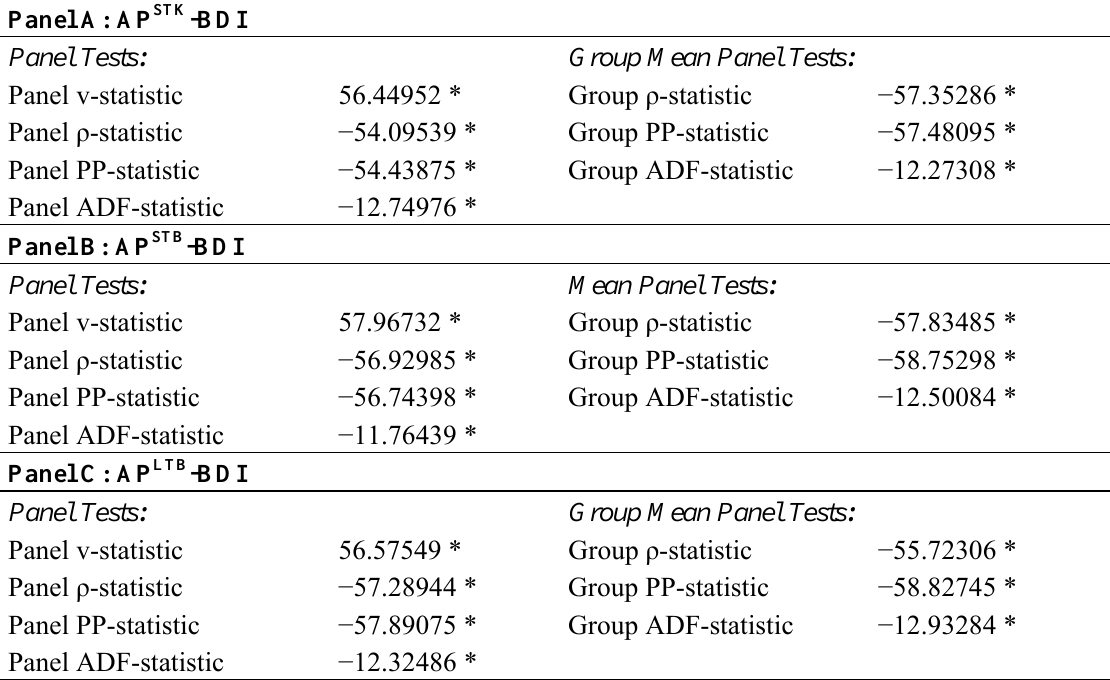
Table 2. Panel cointegration